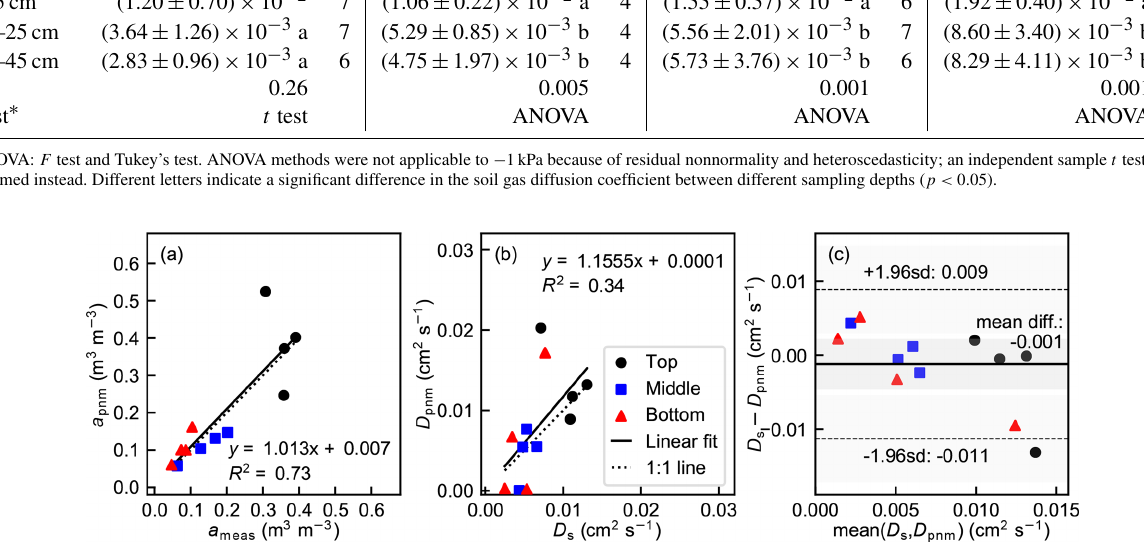
Figure 1. (a) Comparison of measurement-derived air-filled porosity ( a meas ) at − 3kPa matric potential and the air-filled porosity of corre- sponding pore networks ( a pnm ) for peat samples from the depths of 0–5cm (top), 20–25cm (middle), and 40–45cm (bottom). The determi- nation of a meas was performed by subtracting the measured volumetric water content from the total porosity of the sample. (b) Comparison of soil gas diffusion coefficients determined from measurements ( D s ) at − 3kPa matric potential and obtained through pore network simula- tions ( D pnm ) for peat samples from different depths. (c) Bland–Altman plot showing the difference between the soil gas diffusion coefficients obtained with the two determination methods against the average of the values obtained by the methods for each sample. The solid line rep- resents the mean difference, darker gray shading shows the 95% confidence interval (CI) of the mean difference, and the dashed lines and the lighter gray shading show the 95% limits of agreement and their 95% CI,